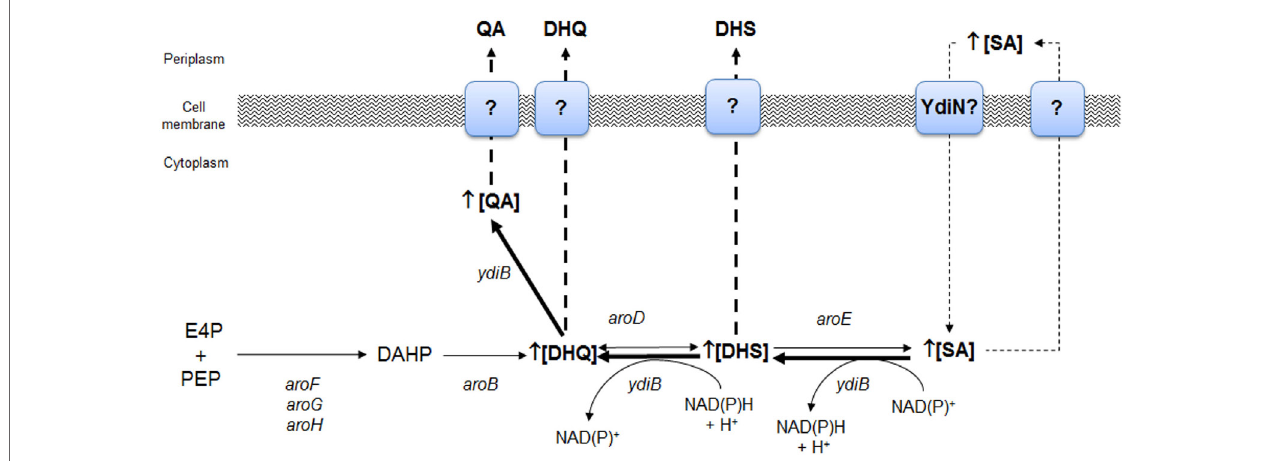
FiGURe 4 | identification of key genes of the SA pathway involved in the biosynthesis of aromatic byproducts QA and DHS from SA as determined by global transcriptomic analysis in E. coli w3110.shik1 . Overexpression of ydiB , aroD , and ydiN genes allowed proposing that under carbon limiting growth conditions, SA is intracellularly accumulated as consequence of an inefficient export to periplasmic space or as consequence of its back transport to the cytoplasm as consequence of extracellular accumulation. YdiN, a putative transporter coded by ydiN was proposed to be involved in SA back import. Backflow of SA to DHS was possibly catalyzed by YdiB, whereas synthesis of DHQ from DHS was performed by AroD enzyme and finally, YdiB performed synthesis of QA from DHQ. Adapted from Johansson and Lidén